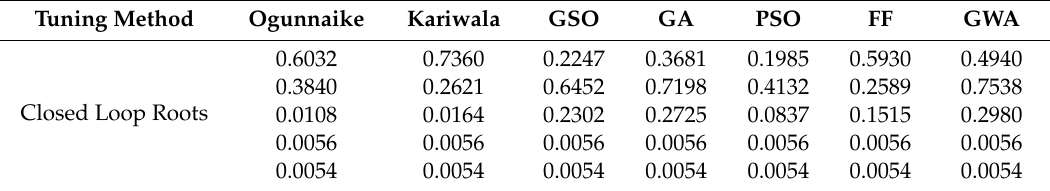
Table 13. Example 2: Closed loop roots with di ff erent tuning methods.